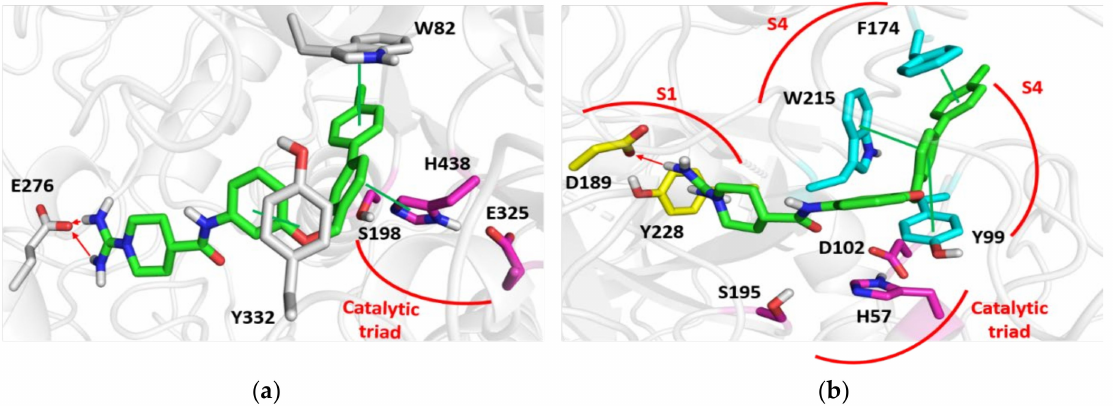
Figure 4. Top-scored docking poses of compound 23 vs. BChE ( H. Sapiens, PDB_ID: 6SAM) and vs. fXa ( H. Sapiens , PDB_ID: 3K9X) are shown on the left ( a ) and right ( b ) hand-side, respectively. Catalytic triads are colored in magenta. Green lines and red arrows indicate π – π interactions and hydrogen bonds, respectively. Pockets S1 (yellow sticks) and S4 (cyan sticks) in the fXa binding site are flagged in red. Docking score values were equal to − 9.861 and − 10.663 kcal/mol for 23 vs. BChE and vs. fXa, respectively.